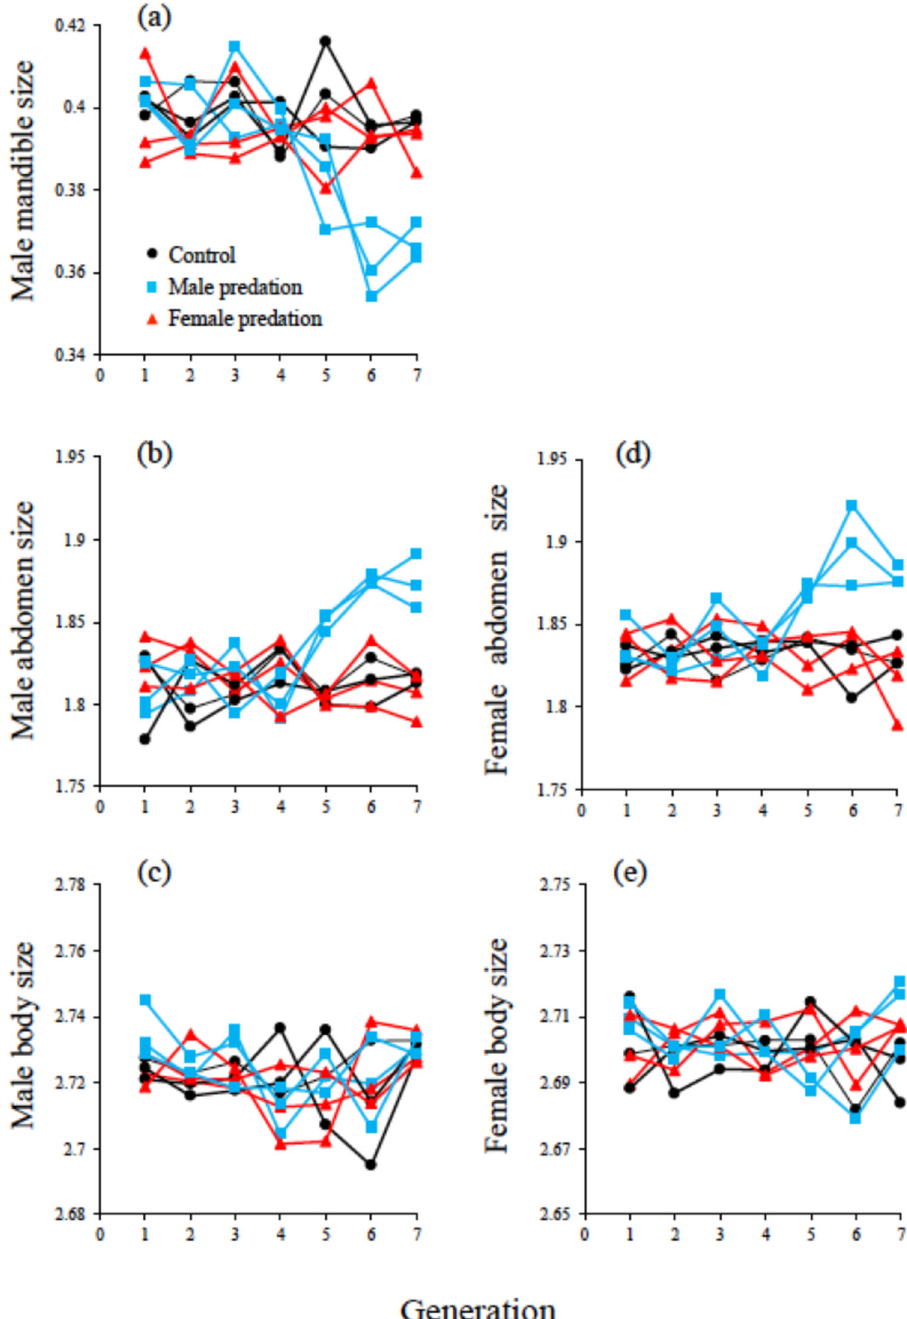
Fig. 1 Responses to sex-speci fi c selection through predation over seven generations. Shown are male mandible size (mm) ( a ), male abdomen size (mg) ( b ), male body size (mg) ( c ), female abdomen size (mg) ( d ) and female body size (mg) ( e ) (population means). Black circles are the control populations that were not subjected to selection by predation. Blue squares and red triangles, are the populations with male and female exposure to predators, respectively. Note we did not measure female fi tness (lifetime reproductive success: LRS) at every generation as it was not logistically possible. Population means (estimated by measuring 50 male and females per generation), for each population/treatment are shown because only populations evolve and thus population is the biologically relevant unit of replication in an experimental evolution study. Source data are provided as a Source Data fi